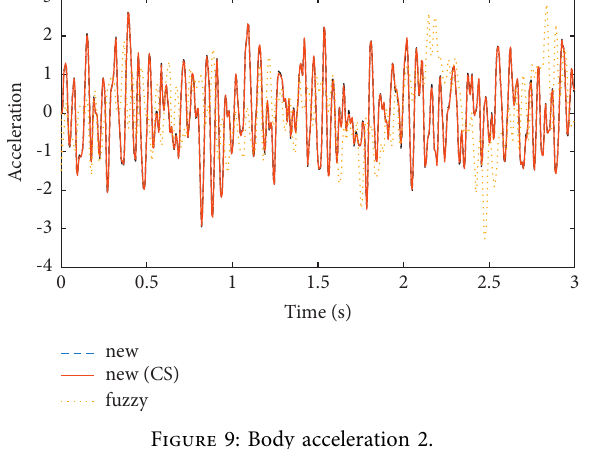
Figure 9: Body acceleration 2.